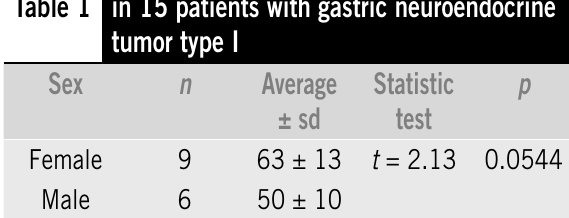
Comparison of mean age in relation to sex in 15 patients with gastric